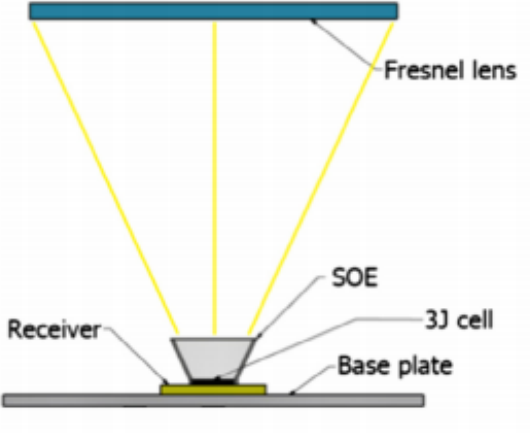
Figure 28. Solar concentrator consisting of Fresnel lens and pyramid proposed by Renzi et al. [53]. Reprinted from M. Renzi et al., Design and experimental test of refractive secondary optics on the electrical performance of a 3-junction cell used in CPV systems. Applied Energy 2017, 185, 233–243, with permission from